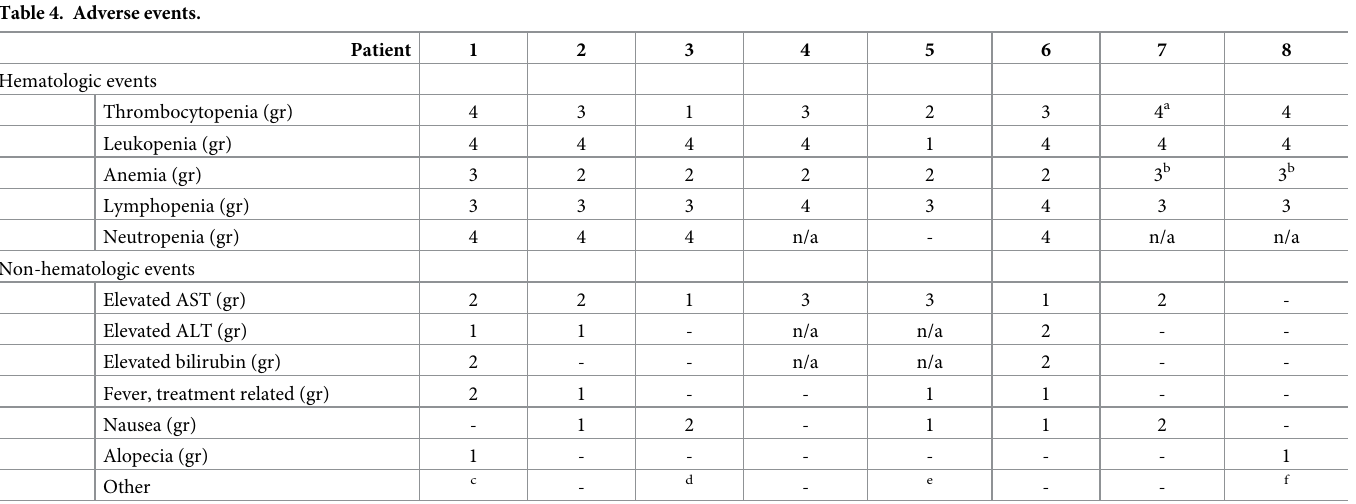
Table 4. Adverse